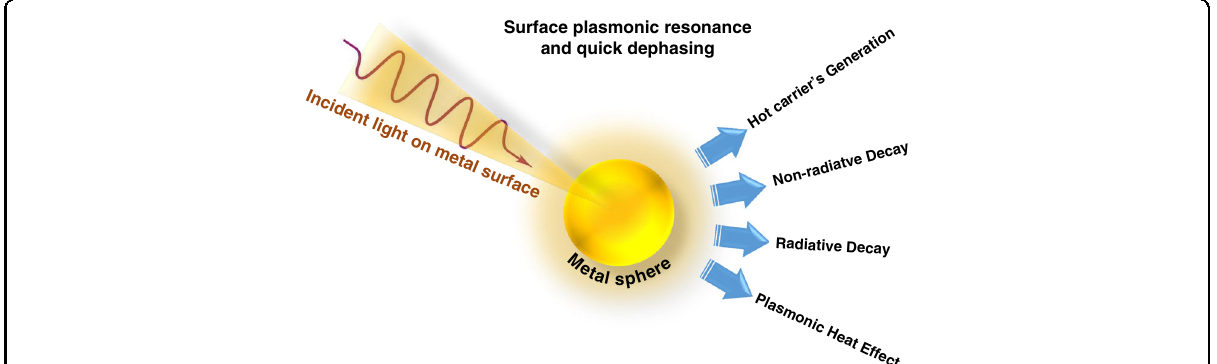
Fig. 16 Representation of the dephasing of plasmons and their energy dissipation mechanism. Energy released through four mechanisms: HC generation, nonradiative decay, radioactive decay, and plasmonic heating